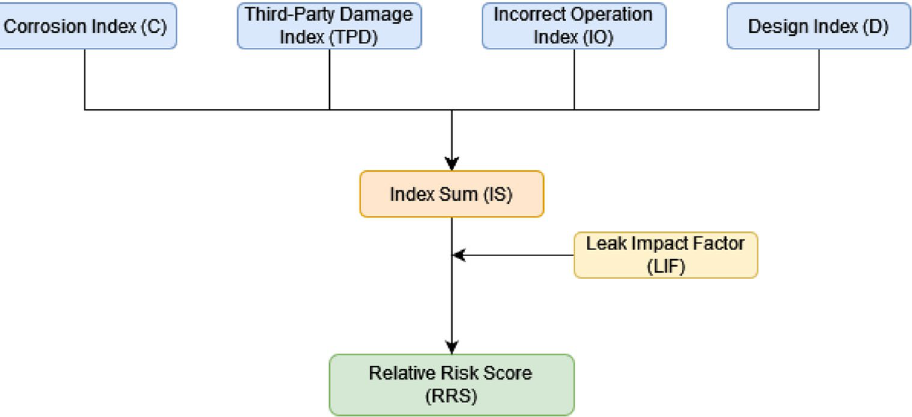
Figure 1. The basic risk assessment model.